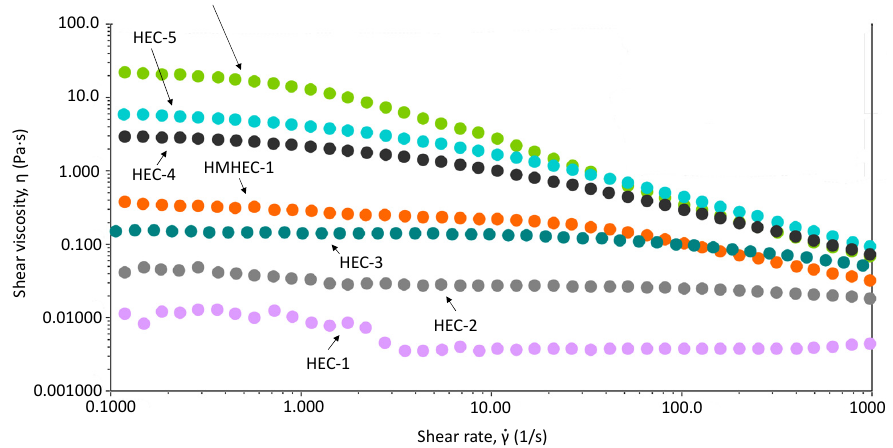
550,000 kDa) could be compared with HEC-4 and HEC-5, which have molecular weights of 1,000,000 and 1,300,000 kDa, respectively. Flow curves for the HPC variants are provided in Figure 3. The shear viscosity of these variants is similar in magnitude to that obtained for the HEC analogues. The molec- ular weight range is similar for the tested HEC and HPC variants, which is the largest contributing factor to viscosity magnitude. Figure 2. Shear viscosity plotted as a function of shear rate for variants of HEC and HMHEC. Not surprisingly, hydrophobically modified HEC variants (HMHEC-1 and HMHEC- 2) have higher viscosity than corresponding HEC analogues with similar molecular weight. For example, a good comparison would be HEC-1 (M w = 90,000 kDa) and HEC-2 (M w = 300,000 kDa) with HMHEC-1 (M w = 350,000 kDa). Likewise, HMHEC-2 (M w =